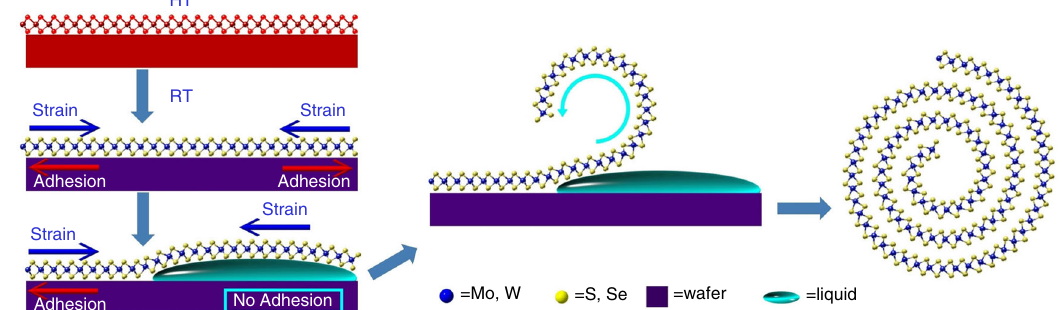
Fig. 1 Schematic of self-scrolling of chemical vapor deposition (CVD)-based transition metal dichalcogenide (TMD) monolayer fl akes. A proposed series of steps leading to the formation of TMD-NSs is shown: (I) initial TMD monolayer growth on a substrate at a high temperature (HT) (e.g., 720, 825 °C); (II) the generation of a strain, balanced with the adhesion from substrate, in the TMD monolayer while cooling down to room temperature (RT); (III) the insertion of liquid between the TMD monolayer and substrate and the disappearance of the adhesion; (IV) the TMD fl akes curve out of the plane driven by the strain; (V) the fi nal formation of